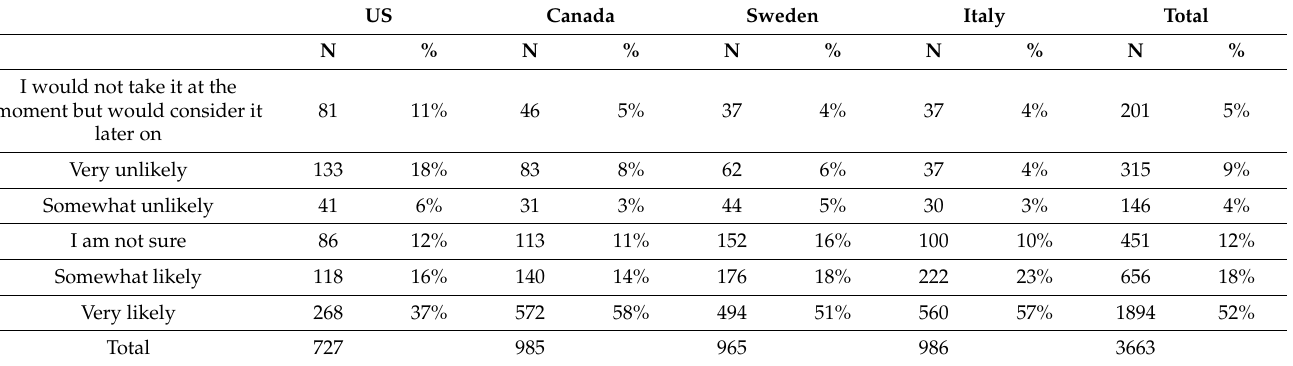
Table 1. Distribution of Vaccine Hesitancy by